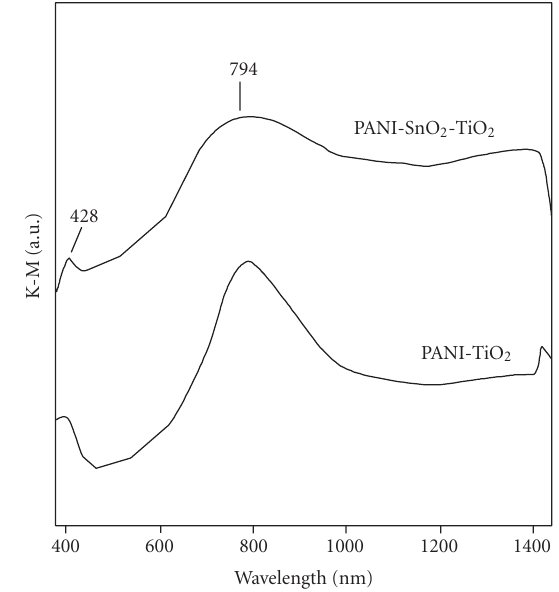
Figure 3: UV-Vis DR spectra of photocatalysts in the range of wave- length from 400 to 1400 nm.